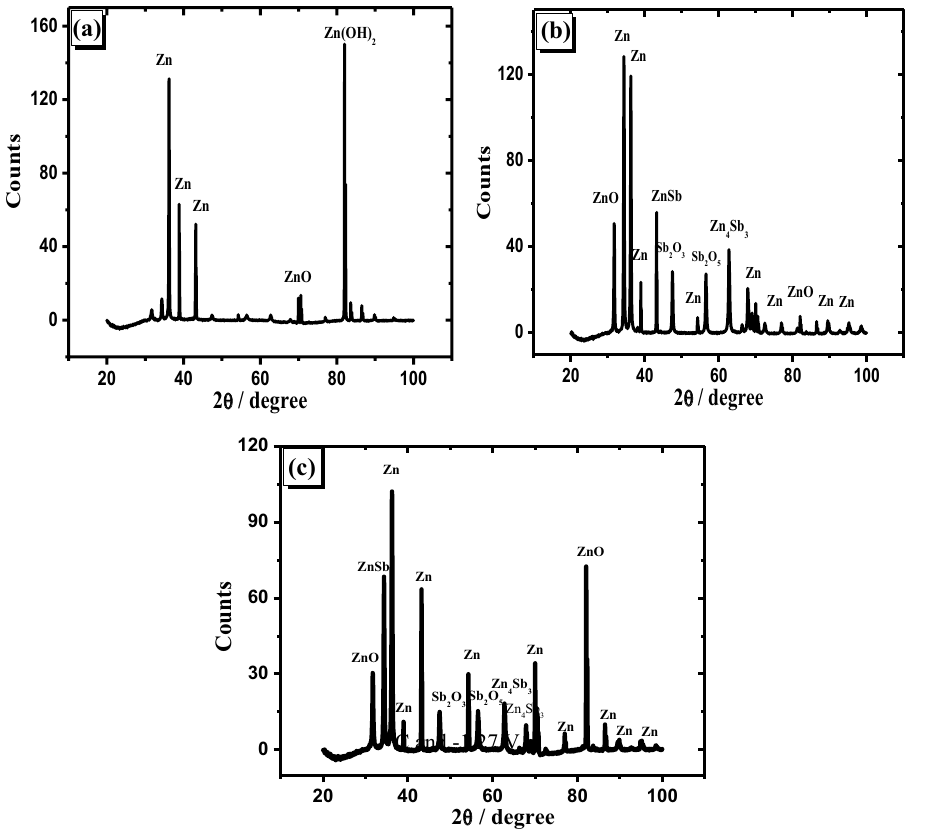
Figure 7. Patterns of XRD for anodically generated oxide film on zinc ( a ) and its alloys I ( b ), and II ( c ) in 6 M KOH at 25 °C and − 1.27